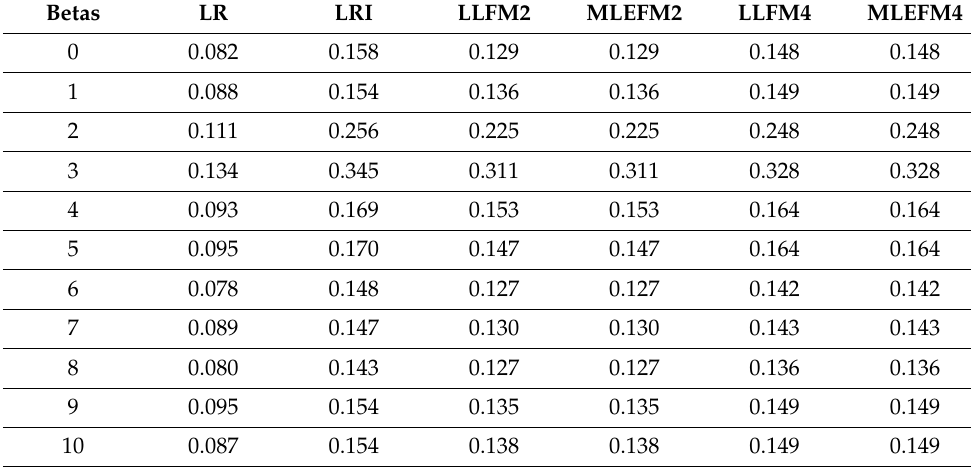
Table 3. Standard deviation of predictor coefficient estimates over 200 repetitions for N = 1000 for logistic regression (LR), logistic regression with interaction (LRI), two factor factorisation machine based on logit loss (LLFM2) and maximum likelihood (MLEFM2), and four factorisation machines (LLFM4 and MLEFM4).